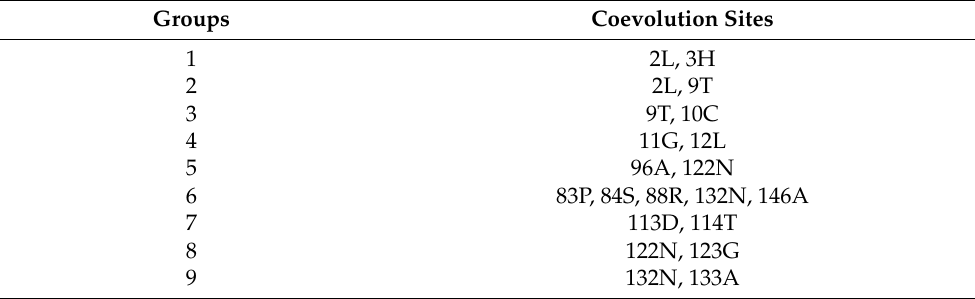
Table 3. Coevolutionary sites of the TaGATA family *.